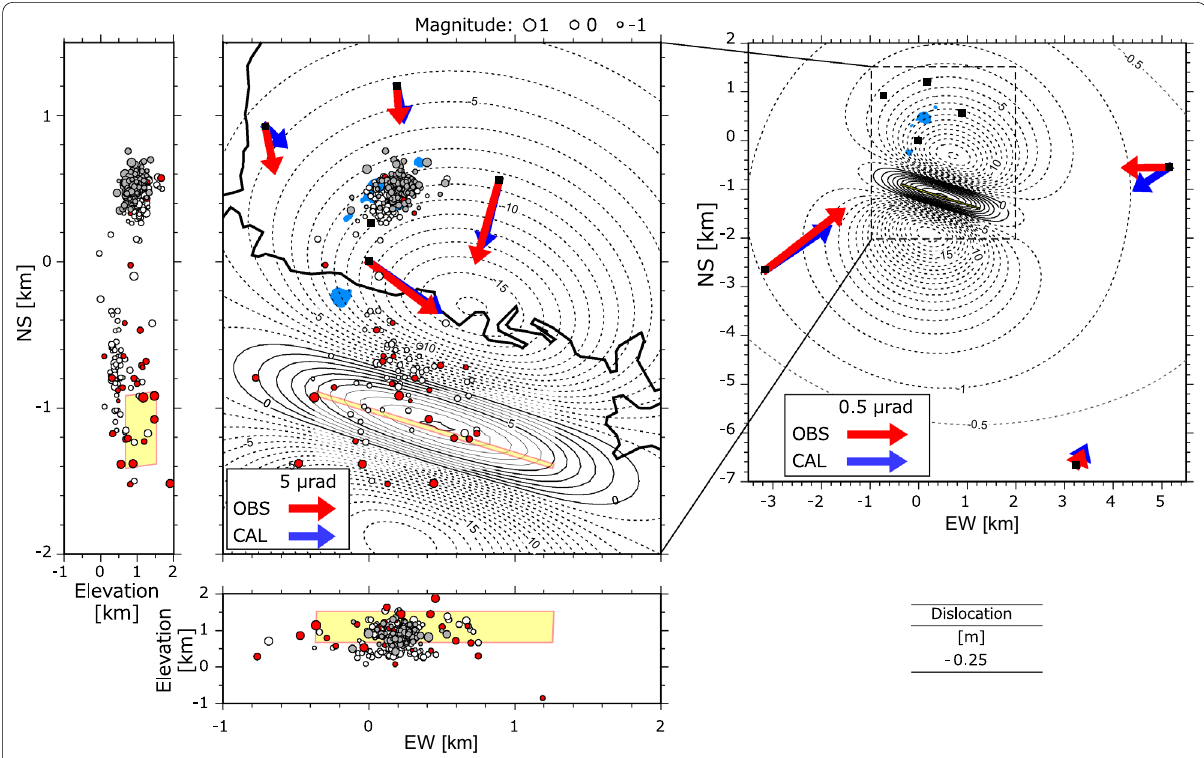
Fig. 7 Comparison of observed (red arrows) and modeled (blue arrows) tilt vectors of phase 2 (Fig. 3). The location of the modeled crack is represented by the yellow rectangle. Modeled vertical displacement is projected onto a virtual plane at 2100 m asl (corresponding to an altitude of MC) at intervals of 1 mm. Solid and broken contour lines correspond to vertical uplift and subsidence, respectively. White, red, and gray circles represent hypocenters determined by the KSVO for the period from 1 January 2016 to 22 January 2018 (before the eruption), from 23 January to 22 April 2018 (after the eruption), and from 22 to 23 April 2018 (representative of SPCG unrest in 2018), respectively. Vertical N–S and E–W cross-sections of hypocenters are also shown. The optimal dislocation of the crack is shown at lower right in the figure; other crack parameters are as in Fig.